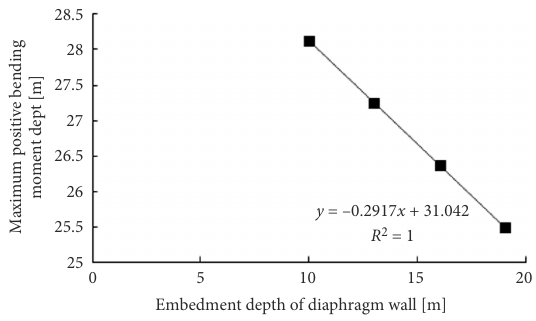
Figure 15. Effect of embedment depth on position of maximum positive